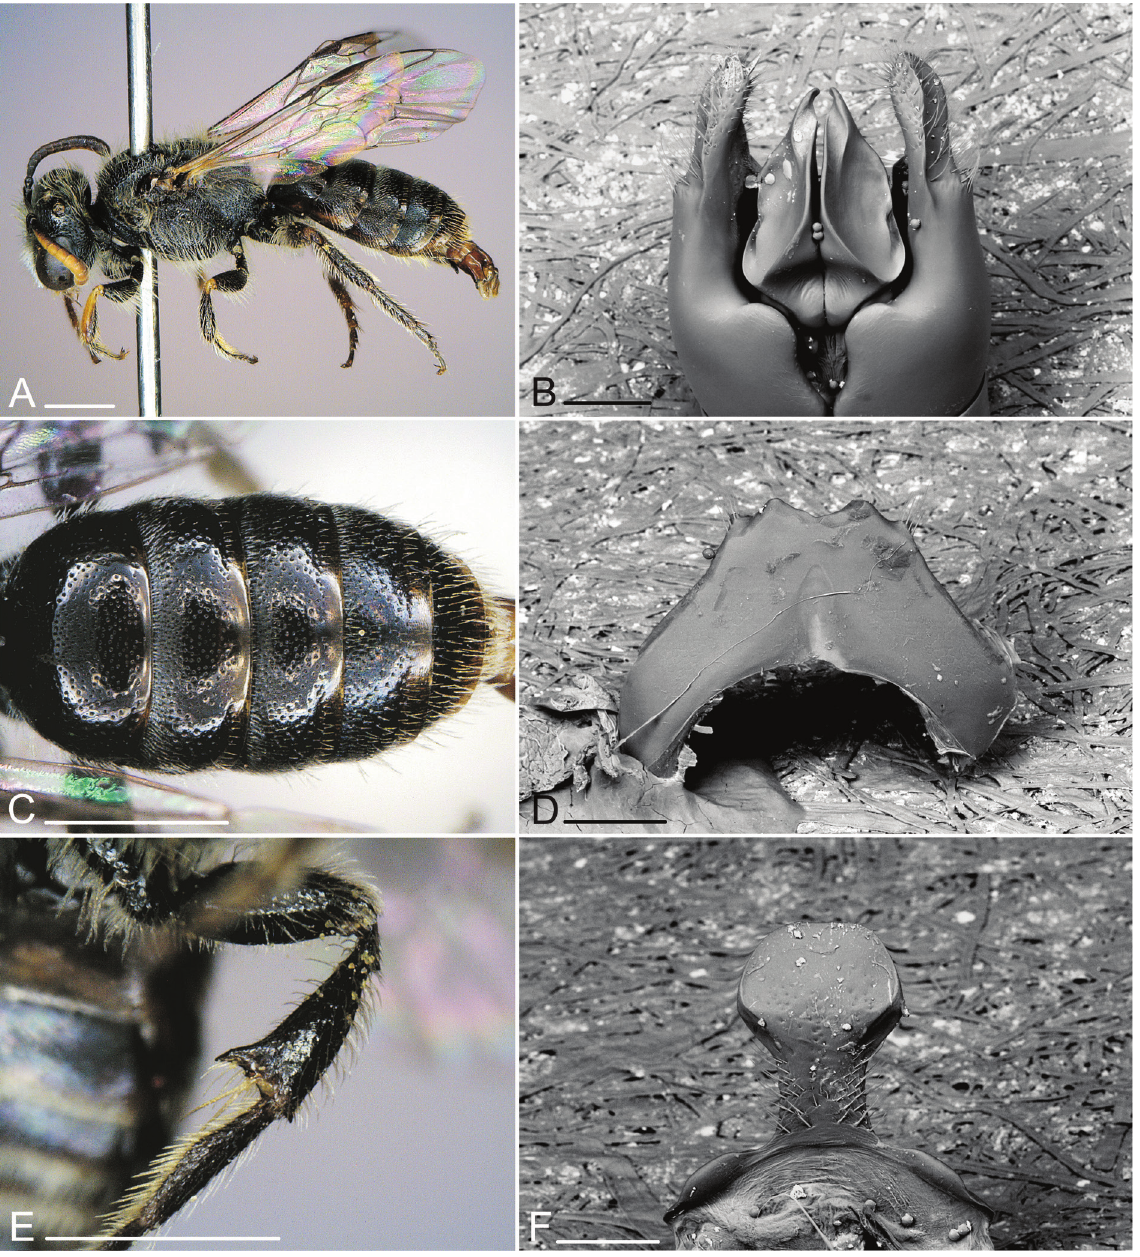
Fig. 2. Scrapter acanthophorus Davies, 2005, ♂. A . Lateral view. B . Genitalia (dorsal view, SEM). C . Metasoma (dorsal view). D . S7 (dorsal view, SEM). E . Hind tibia. F . S8, apical end (SEM). Scale bars: photos: 1 mm, SEM: 0.1